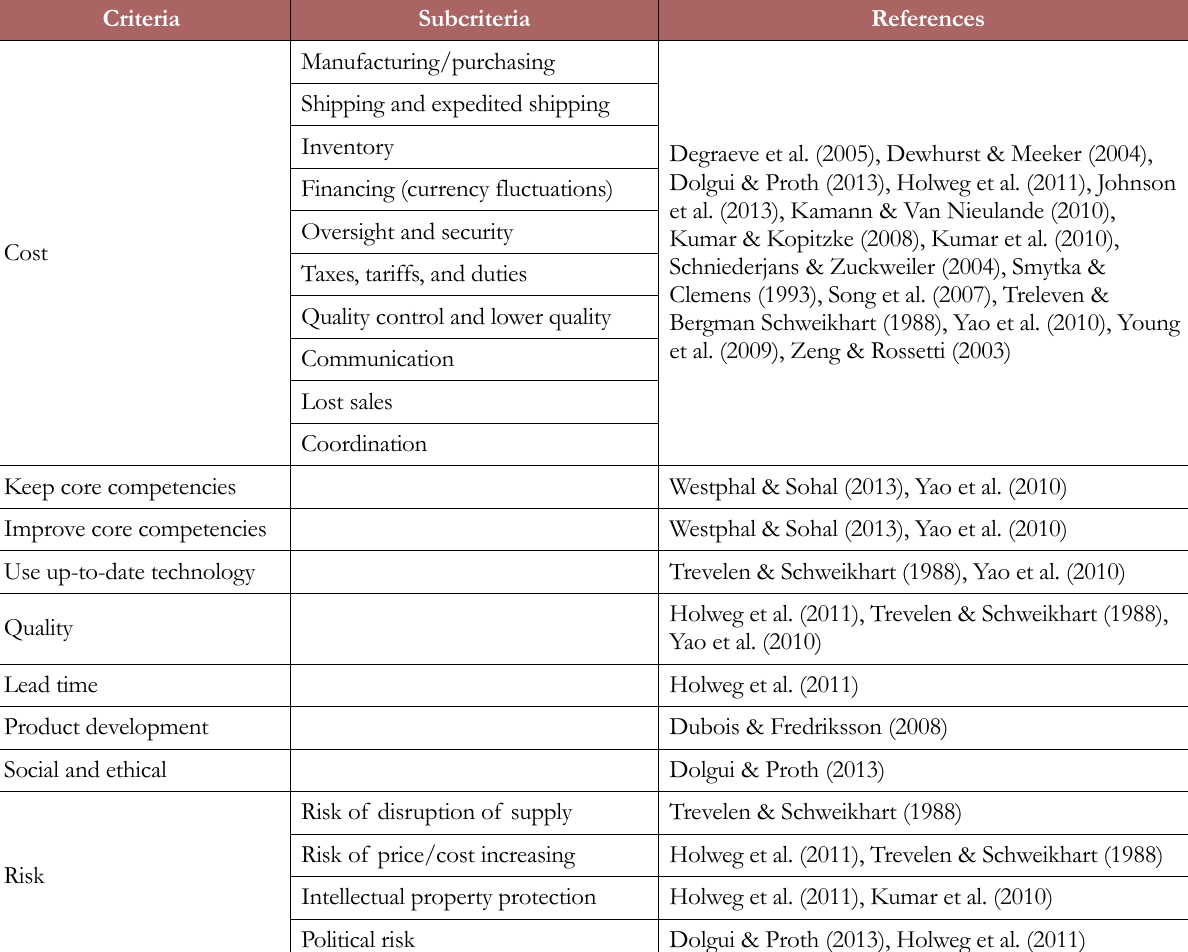
Table 1. Main criteria to consider when assessing strategic sourcing